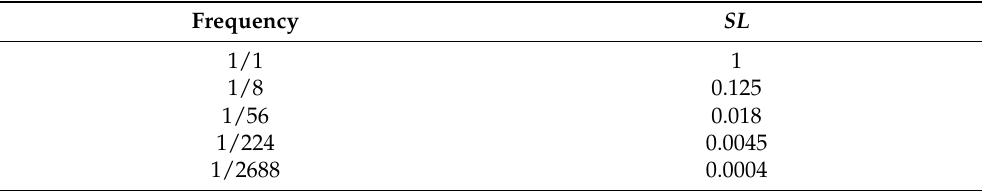
Table 1. Safety level